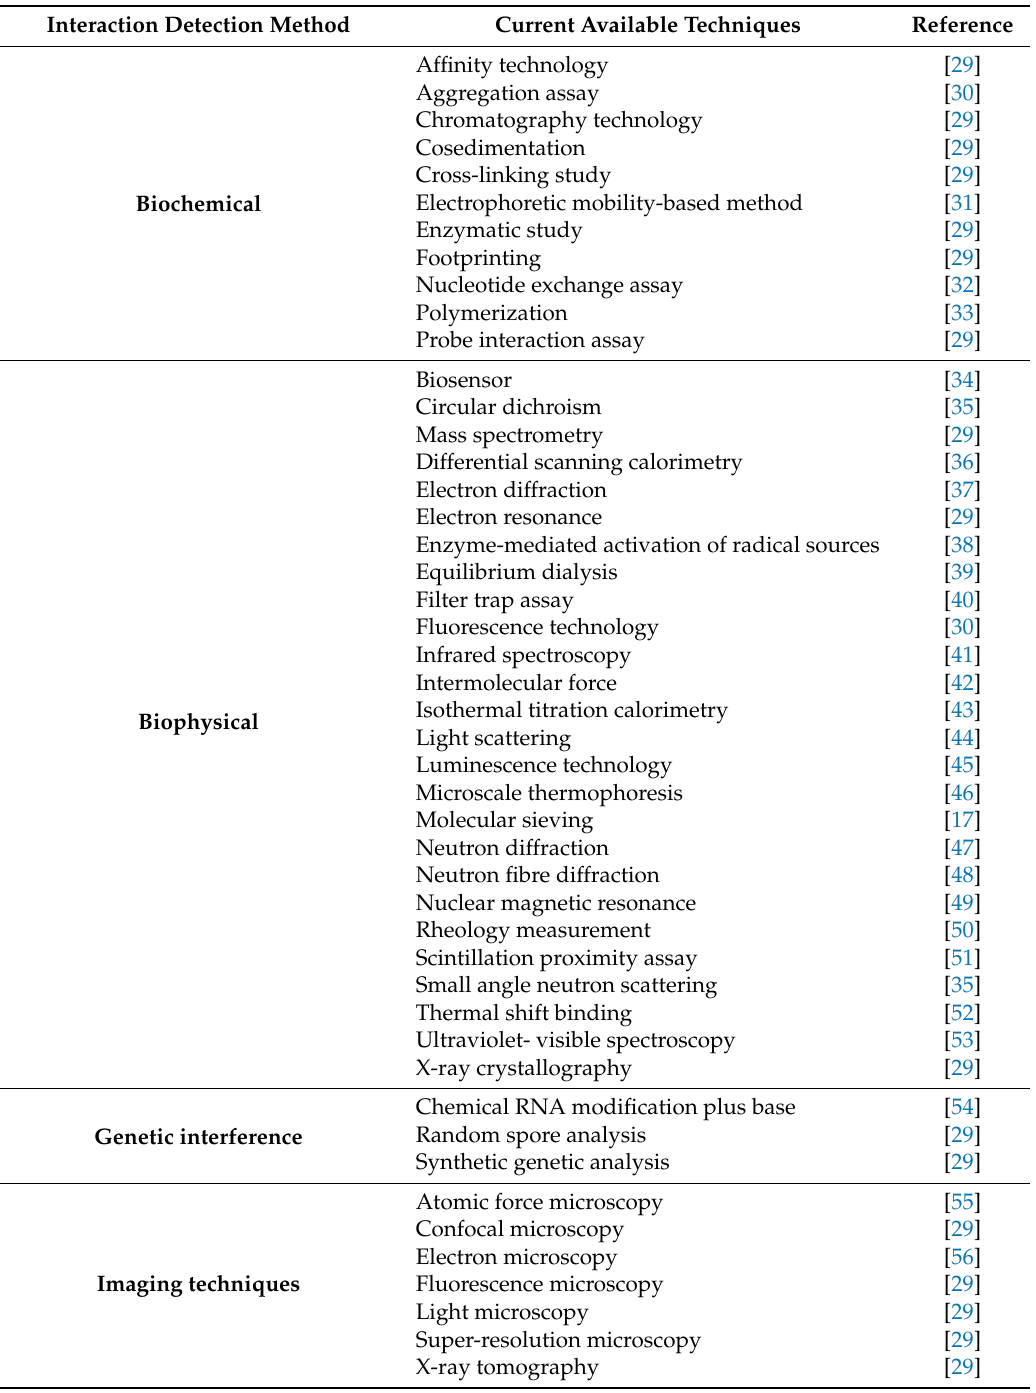
Table 1. Overview of experimental methods for PPI detection and their